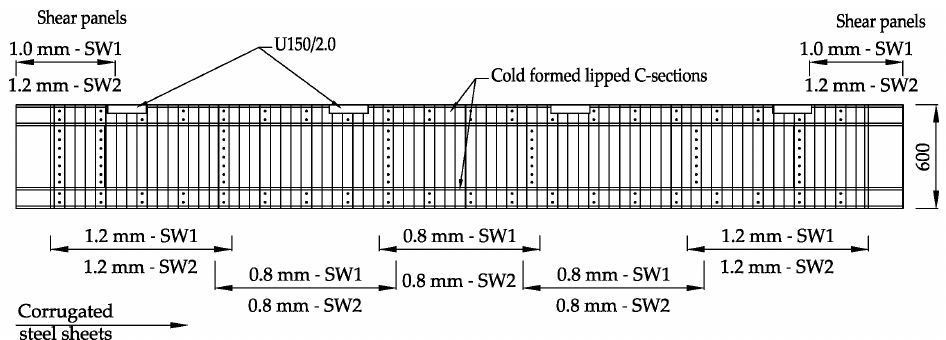
Figure 1. Configuration of the tested built-up beams assembled by spot welding.